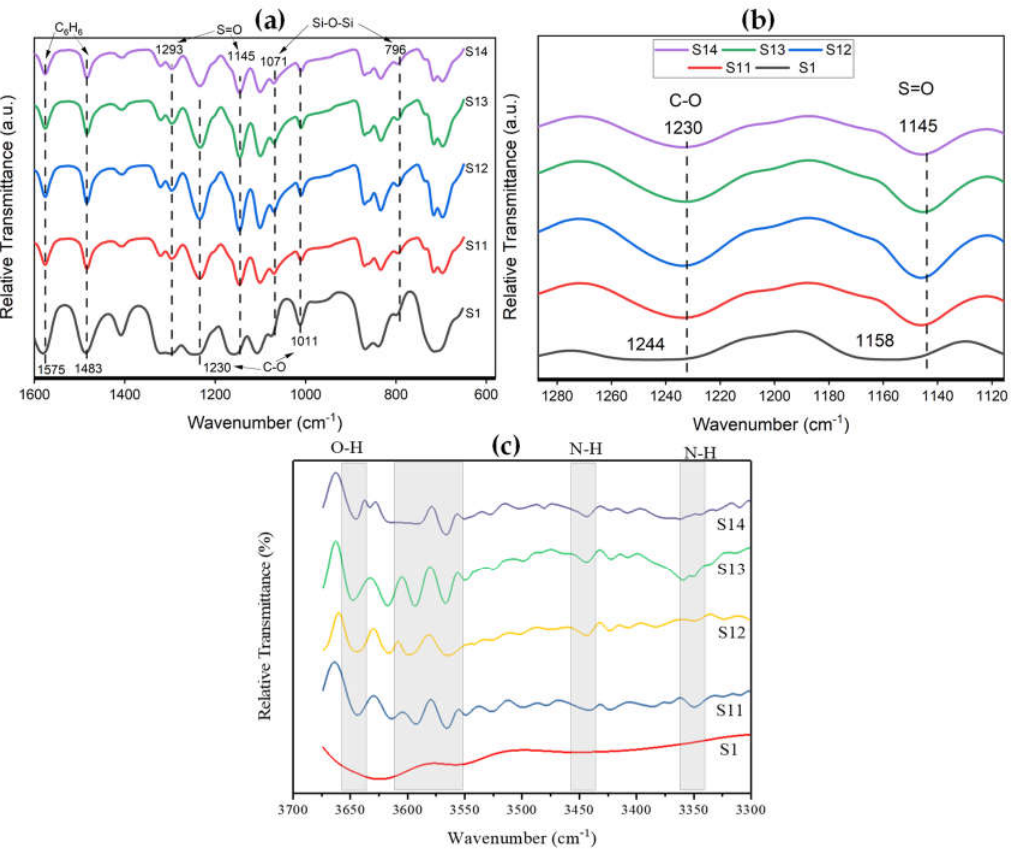
Figure 5. FTIR spectra of PES/modified silica MMMs ( a ) in fingerprint region ( b ) detailed spectra from 1120–1300 cm −1 ( c ) detailed spectra from 3300–3700 cm −1 .